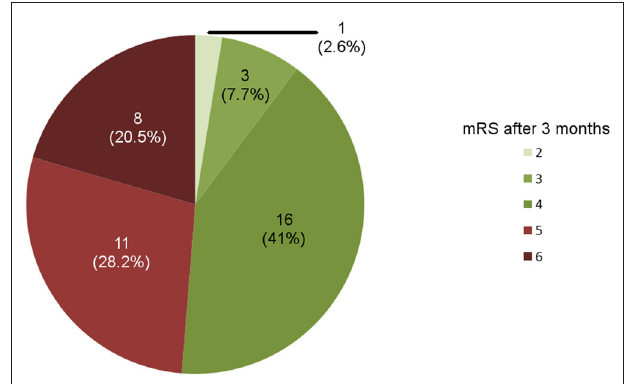
FIGURE 1 | Outcome of patients undergoing decompressive surgery for large hemispheric infarction as assessed by the modified Rankin Score (mRS) after 3 months ( n =